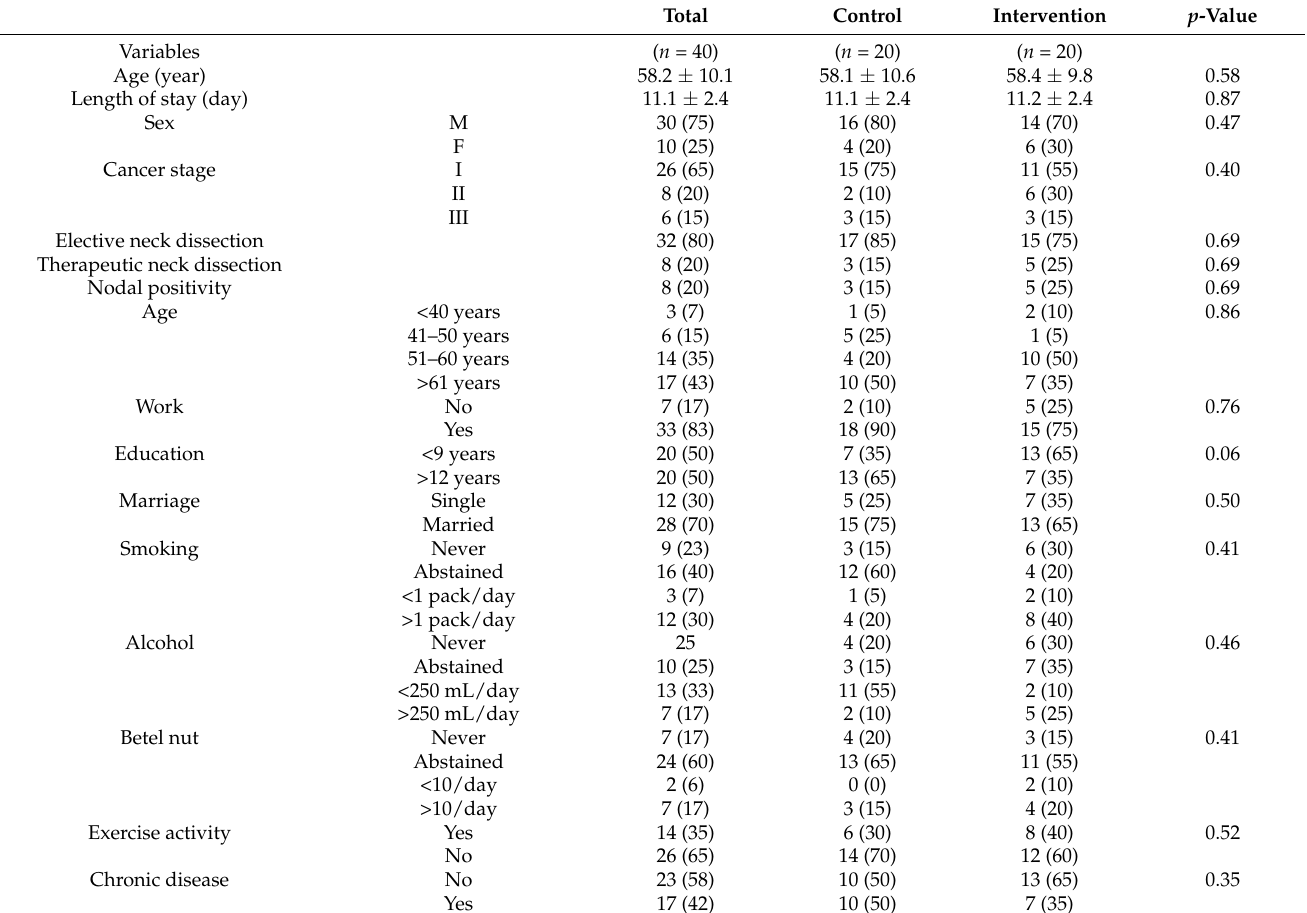
Table 1. Comparison of baseline demographic data and clinical characteristics between the control and intervention